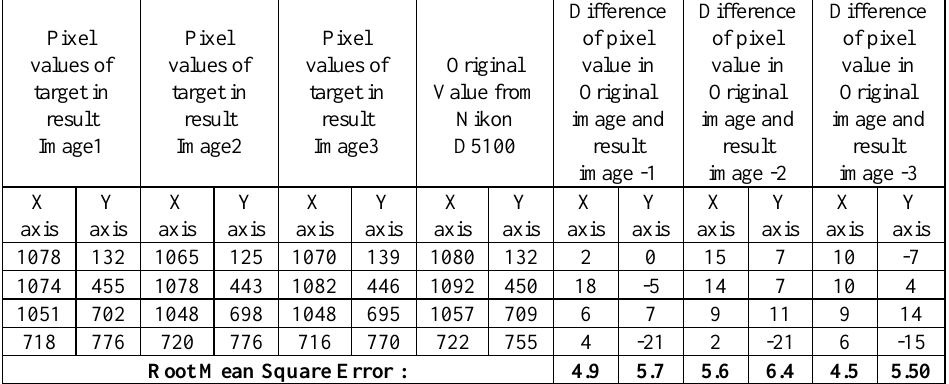
Table 3. Accuracy analysis of the proposed method using the Original Target position captured by Nikon D5100 SLR at 20 m and the result obtained of target by the proposed